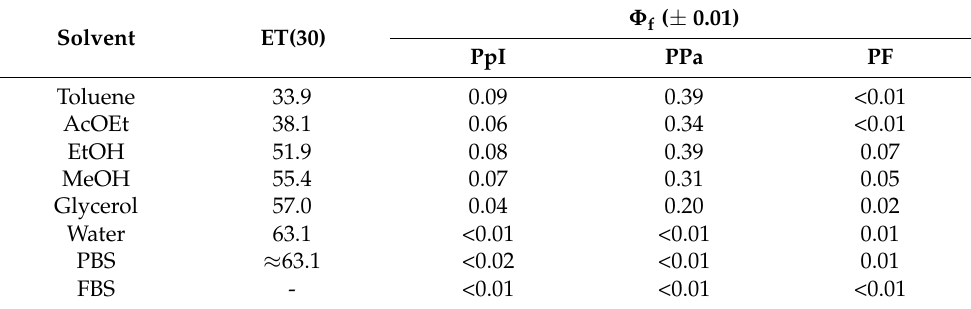
Table 3. Φ f of PpIX, PPa, and PF in different solvents at room temperature ( c = 1.87 μ M).